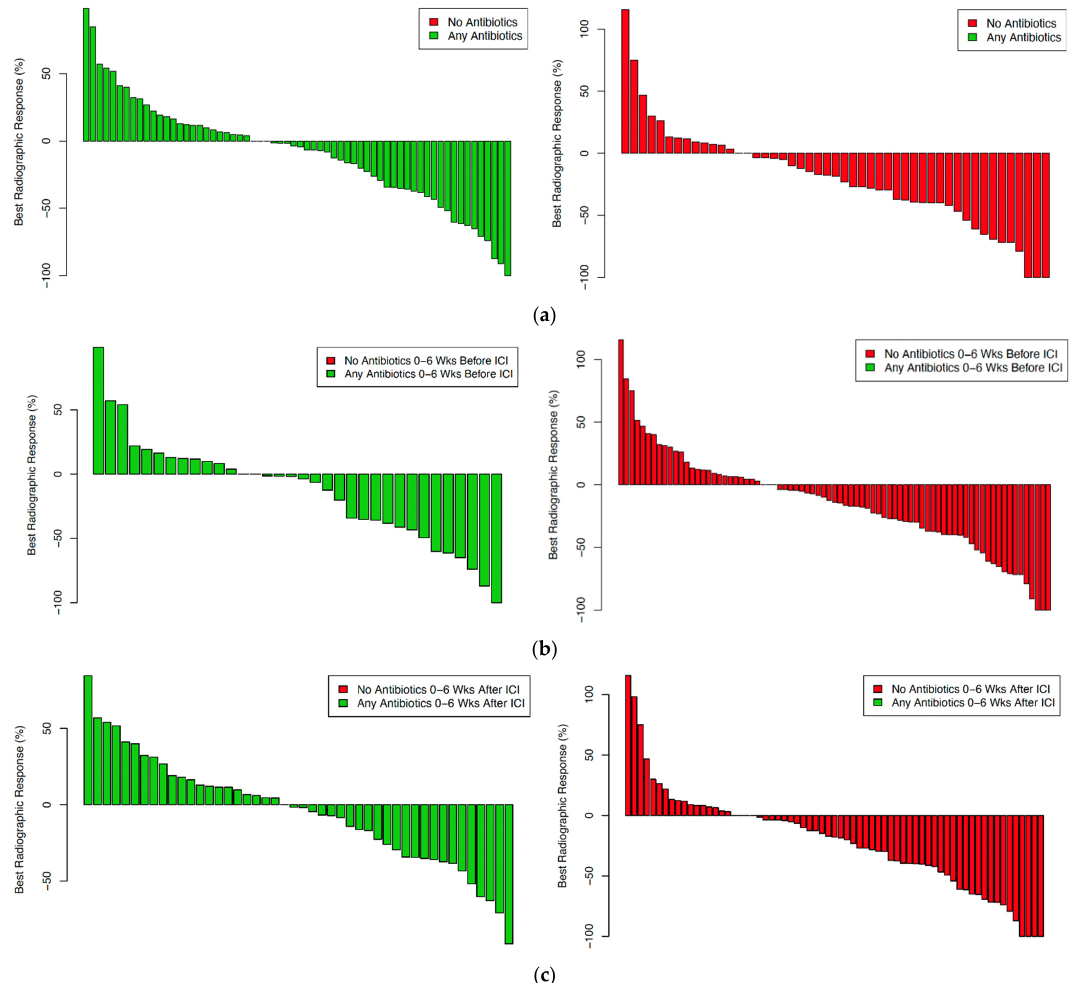
We analyzed systemic immune parameters in the NSCLC cohort, displaying those with significant association with antibiotic exposure in Figure 5. At six weeks, myeloid progenitor inhibitory factor-1 (MPIF-1)/chemokine (C-C motif) ligand 23 (CCL23) was sig- nificantly elevated in patients receiving pre-ICI antibiotics ( p < 0.01, FDR 0.01). When ex- cantly greater changes in patients with pre-ICI antibiotic exposure: interferon-gamma (IFN- γ ) ( p = 0.009, FDR 0.16), interleukin-8 (IL-8)/chemokine (C-X-C motif) ligand 8 (CXCL8) ( p = 0.02, FDR 0.16), macrophage inflammatory protein-1a (MIP-1a)/CCL3 ( p = 0.03, FDR 0.2), and I309/CCL1 ( p = 0.02, FDR 0.16). The fold-change for macrophage in- Figure 4. Best radiographic response according to antibiotic exposure in non-small cell lung cancer cases. ( a ) any antibiotic exposure versus no antibiotic exposure ( p = 0.09); ( b ) antibiotic exposure pre-ICI initiation ( p = 0.74); ( c ) antibiotic exposure post-ICI initiation ( p = 0.02).